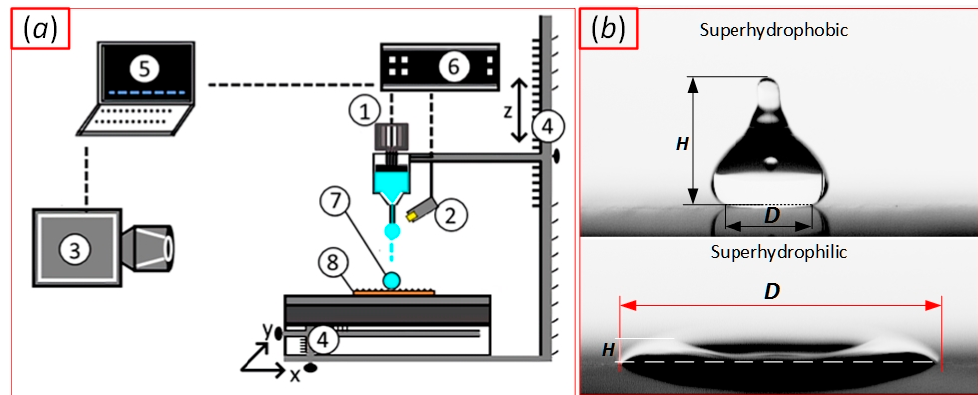
Figure 2. ( a ) Experimental setup for measuring the droplet impact and spreading characteristics on the substrate surface: 1—injection pump, 2—droplet break-away sensor, 3—high-speed video camera Phantom VEO710, 4—3-axis positioning table, 5—computer, 6—microcontroller unit, 7—droplet, 8—substrate. ( b ) Typical snapshots of droplet spreading on superhydrophilic and superhydrophobic